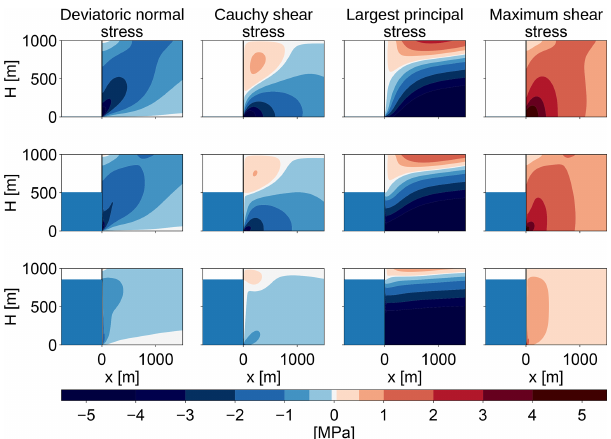
Figure 2. Stress configurations at the calving front for different rel- ative water depths ( w = 0, 0.5, 0.85) for a fixed ice thickness of 1000m. The first column shows the deviatoric normal stress in the x direction, S xx , the second column shows the Cauchy shear stress, σ xz = S xz , the third column shows the largest principal stress, σ i , and the last column shows the maximum shear stress, τ max